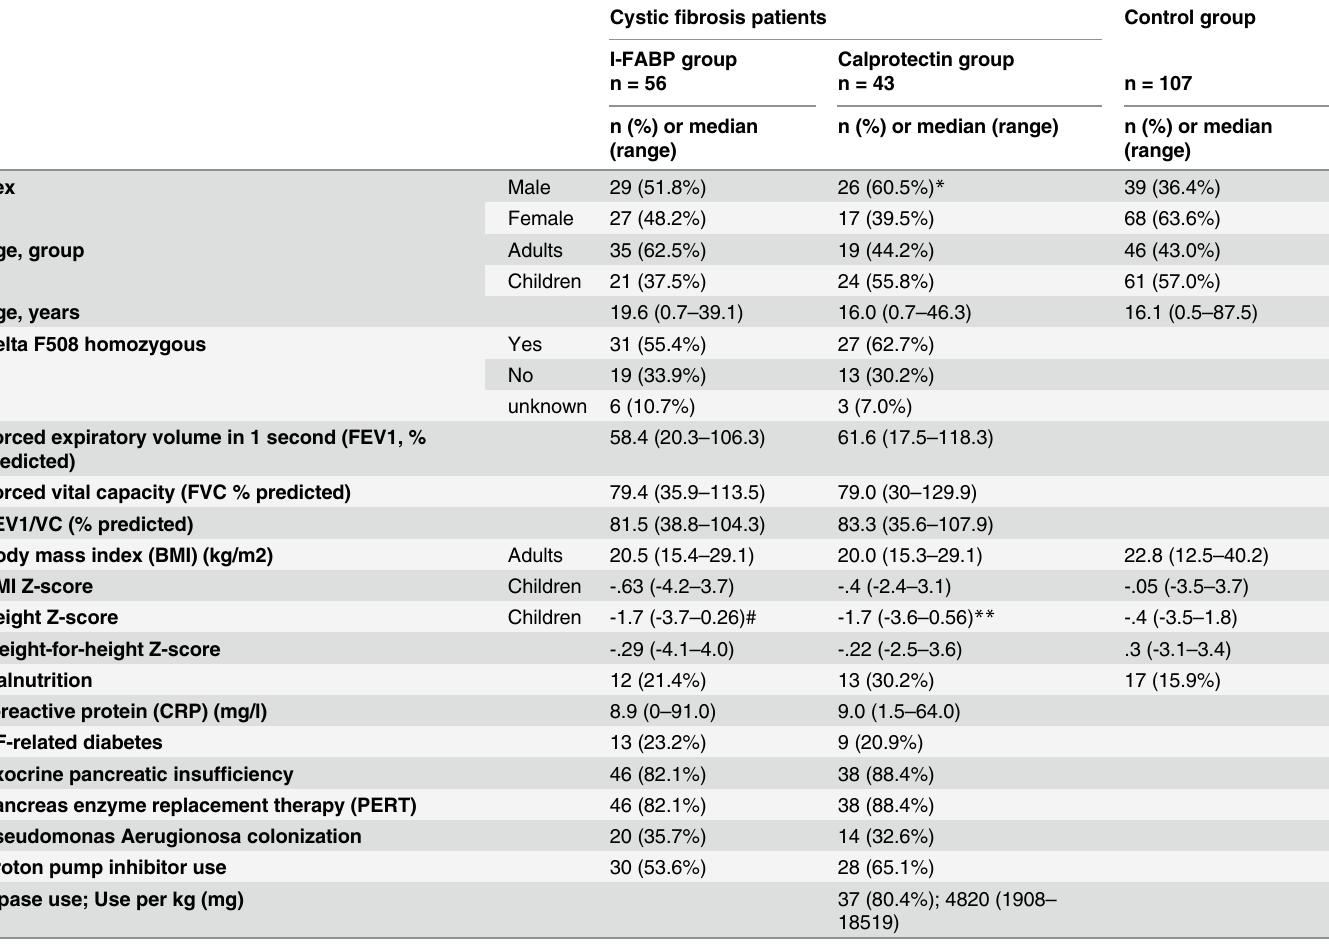
Table 1. Characteristics of cystic fibrosis patients and control